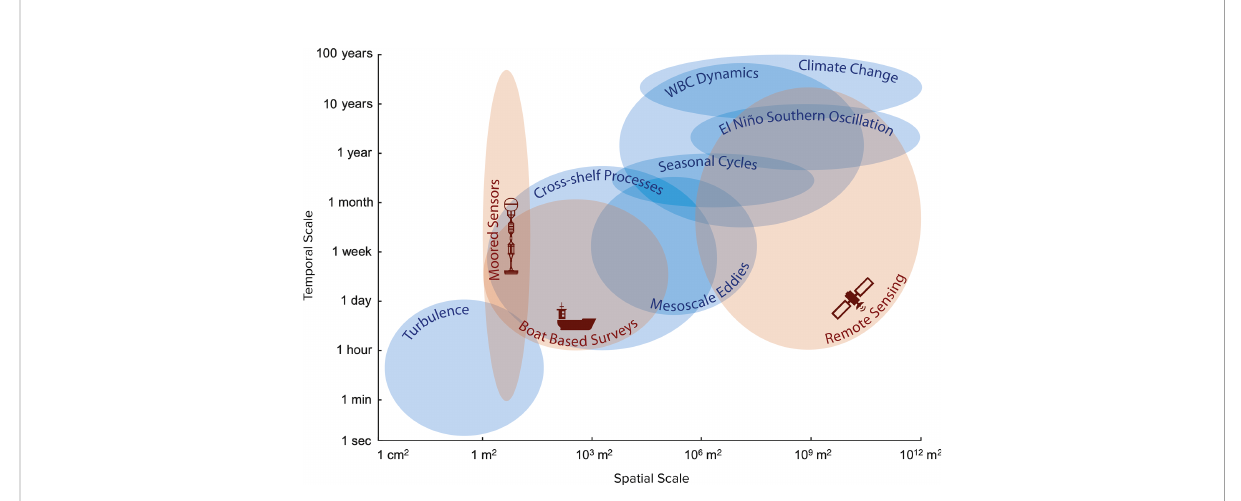
FIGURE 8 Adaptation of a Stommel diagram showing the spatiotemporal scales of variability relevant for Western Boundary currents such as the East Australian Current system (blue) and the observational platforms used in this study